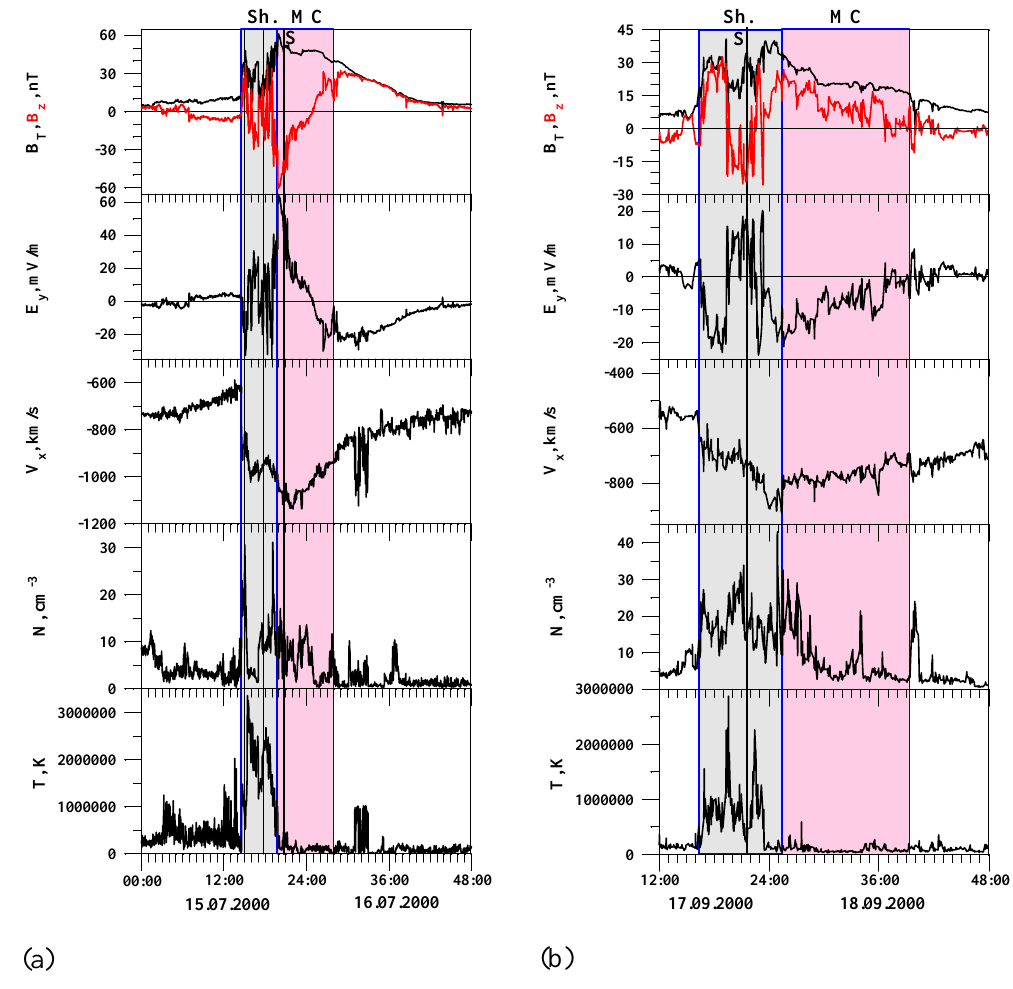
Fig. 1. Total magnetic field B T (black line) and north-south component B Z of IMF (red line), Y-component of the interplanetary electric field E Y , X-component of the solar wind velocity V X , solar wind proton density N and proton temperature T for two cases of MC/Sheath observation close to 1AU. The intervals of observation of MC and Sheath are marked by pink and grey colour, respectively. Vertical blue lines mark the start and finish of MC/Sheath structures. The times of substorm observation onboard the Polar spacecraft are marked by vertical black dashed and solid lines, where the solid line correspond to the time of maximum development of substorm, for which the Polar UVI data are shown below, in Fig.